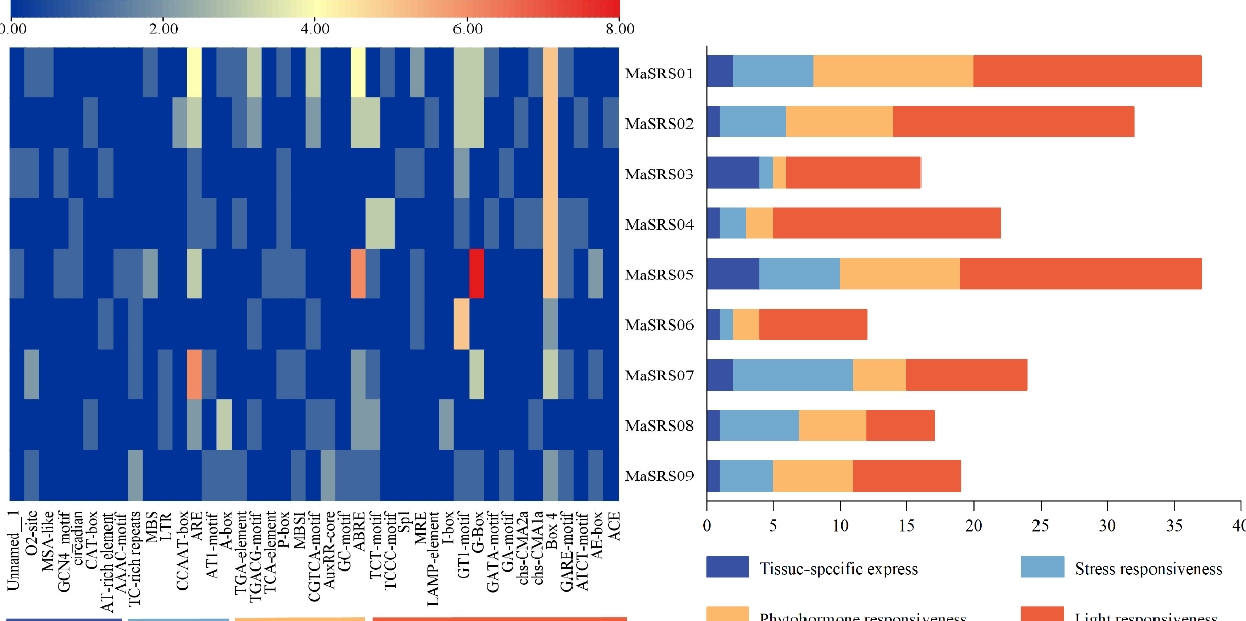
Figure 5. Heat map expression in the promoter region of each MaSRS gene and analysis of the number of cis -acting elements containing the stress response.